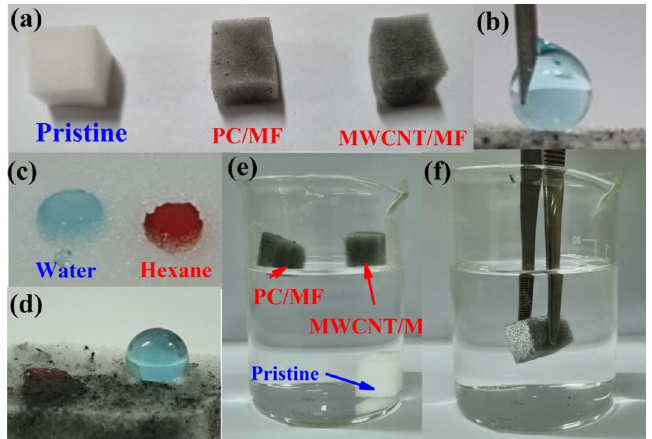
Figure 6. Digital photographs of ( a ) pristine MF, PC/MF, and MWCNT/MF, ( b ) the sessile water droplet method, ( c – e ) wettability behavior of MF and modified-MF, and the silver mirror-like interface by immerging of modified MF onto the water.